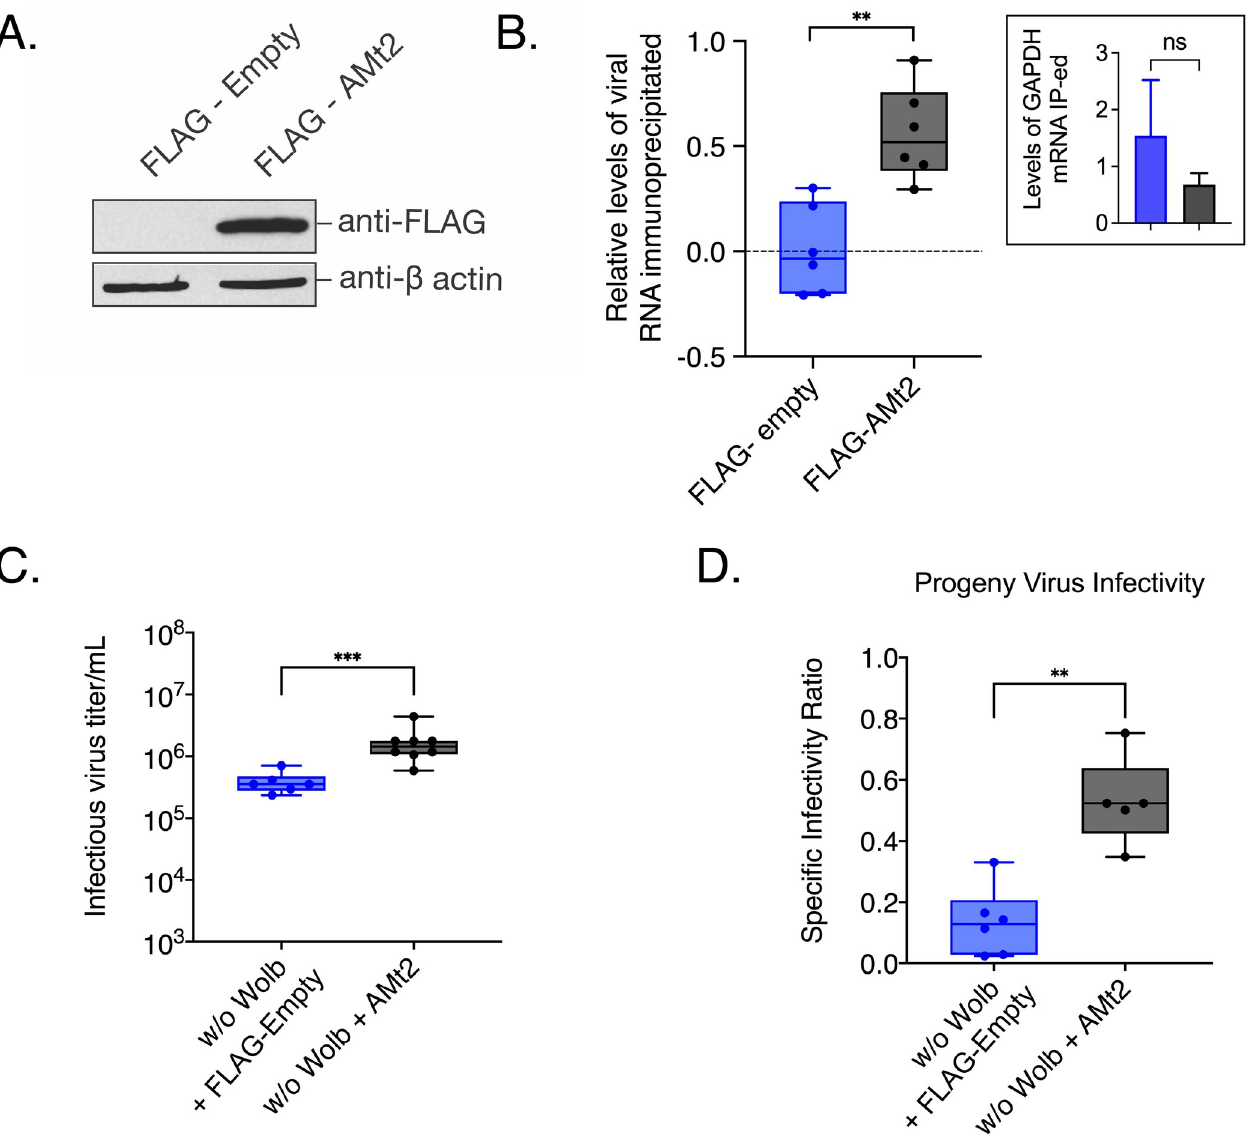
Fig 2. Overexpressing AMt2 in mosquito cells improve progeny virus infectivity. (A) Western Blot of Aedes albopictus (C7/10) cells transfected with expression vector constructs with (FLAG-AMt2) or without (FLAG-empty) AMt2 . Cytoplasmic lysates of cells were collected 48 hours post transfection and probed with anti-FLAG and anti- β actin antibodies. (B) Relative levels of SINV RNA recovered following AZA-IP of AMt2 in C7/10 cells was quantified using qRT-PCR. Wolbachia -free C7/10 mosquito cells were transfected with expression vectors FLAG-empty or FLAG-AMt2 for 48 hours prior to infection with SINV at MOI of 10. Cells were treated for approximately 18h with 5 μ M 5-Azacytidine to covalently trap AMt2 with its target cellular RNA prior to RNA immunoprecipitation using anti-FLAG antibody. The horizontal dotted line represents the threshold set at 1 (log 10 ). Inset bar graph show relative levels of GAPDH mRNA immunoprecipitated with anti-FLAG antibody. Unpaired two-tailed t-test with Welch’s correction, p = 0.0004, t = 4.216, df = 20 (C) Infectious progeny (PFU/mL) SINV produced from mosquito cells Wolbachia -free expressing either FLAG-empty (w/o Wolb) or FLAG-AMt2 (w/o Wolb + AMt2). Cells were transfected 48 hours prior to infection with SINV at MOI of 10. Infectious progeny viruses collected from supernatants 48 hours post- infection were quantified using plaque assays on BHK-21 cells. Unpaired two-tailed t-test with Welch’s correction, p = 0.0002, t = 5.404, df = 11.81. (D) Specific Infectivity Ratios of progeny SINV were calculated as described earlier [1]. Unpaired two-tailed t-test with Welch’s correction, p = 0.0084, t = 3.911, df = 5.820. For all panels error bars represent standard error of mean (SEM) of biological replicates and �� P < 0.01; ���� P <